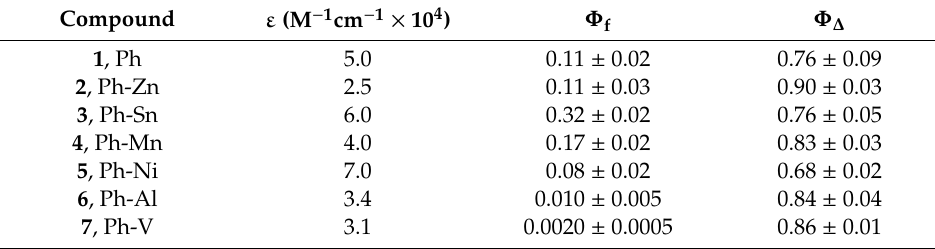
Table 1. Singlet oxygen quantum yield ( Φ ∆ ) and fluorescence quantum yield ( Φ f ) for ( 1 – 7 ).